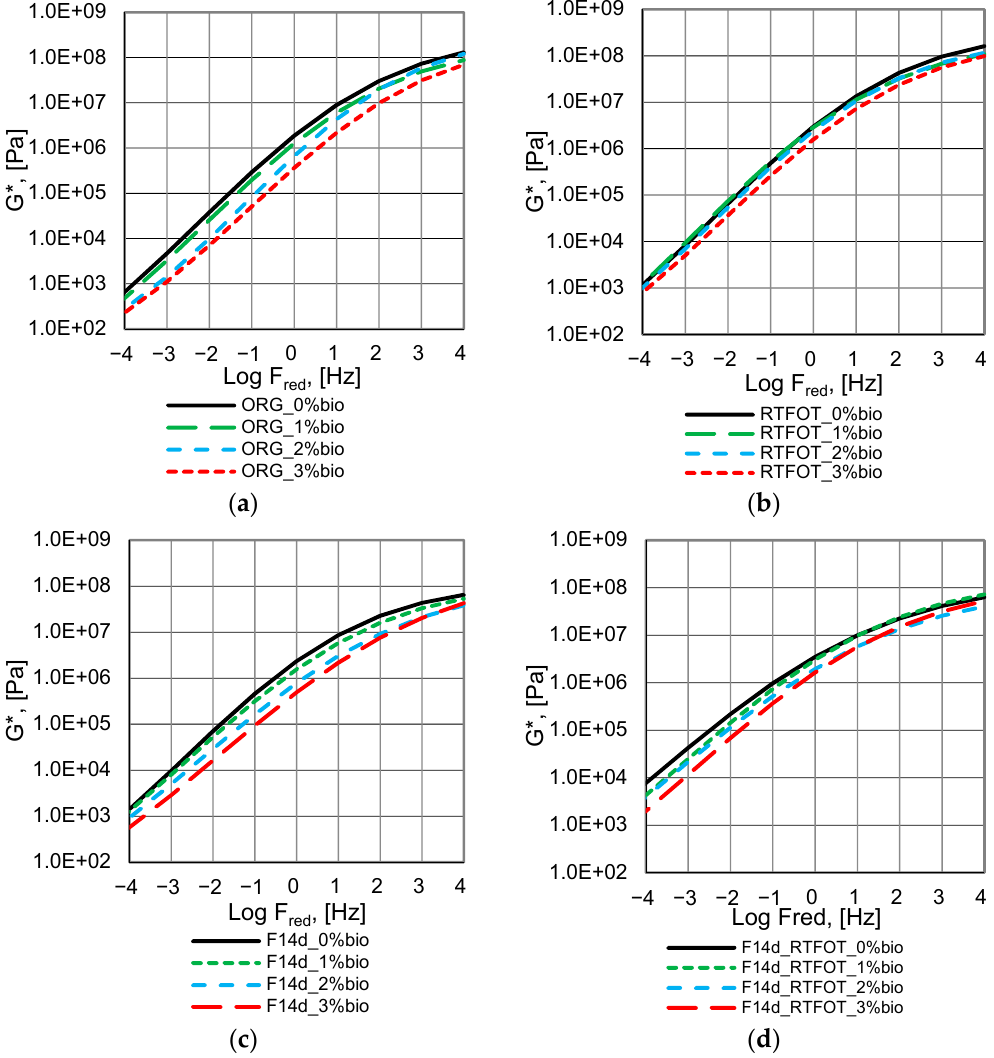
Figure 4. Master curves of complex modulus G* of the 50/70 paving-grade bitumen: ( a ) non-foamed original bitumen (ORG); ( b ) non-foamed after RTFOT ageing bitumen (RTFOT); ( c ) foamed original bitumen (F14d); ( d ) foamed after RTFOT ageing bitumen (F14d_RTFOT). The complex modulus G* master curves of the 45/80–80 highly modified bitumen